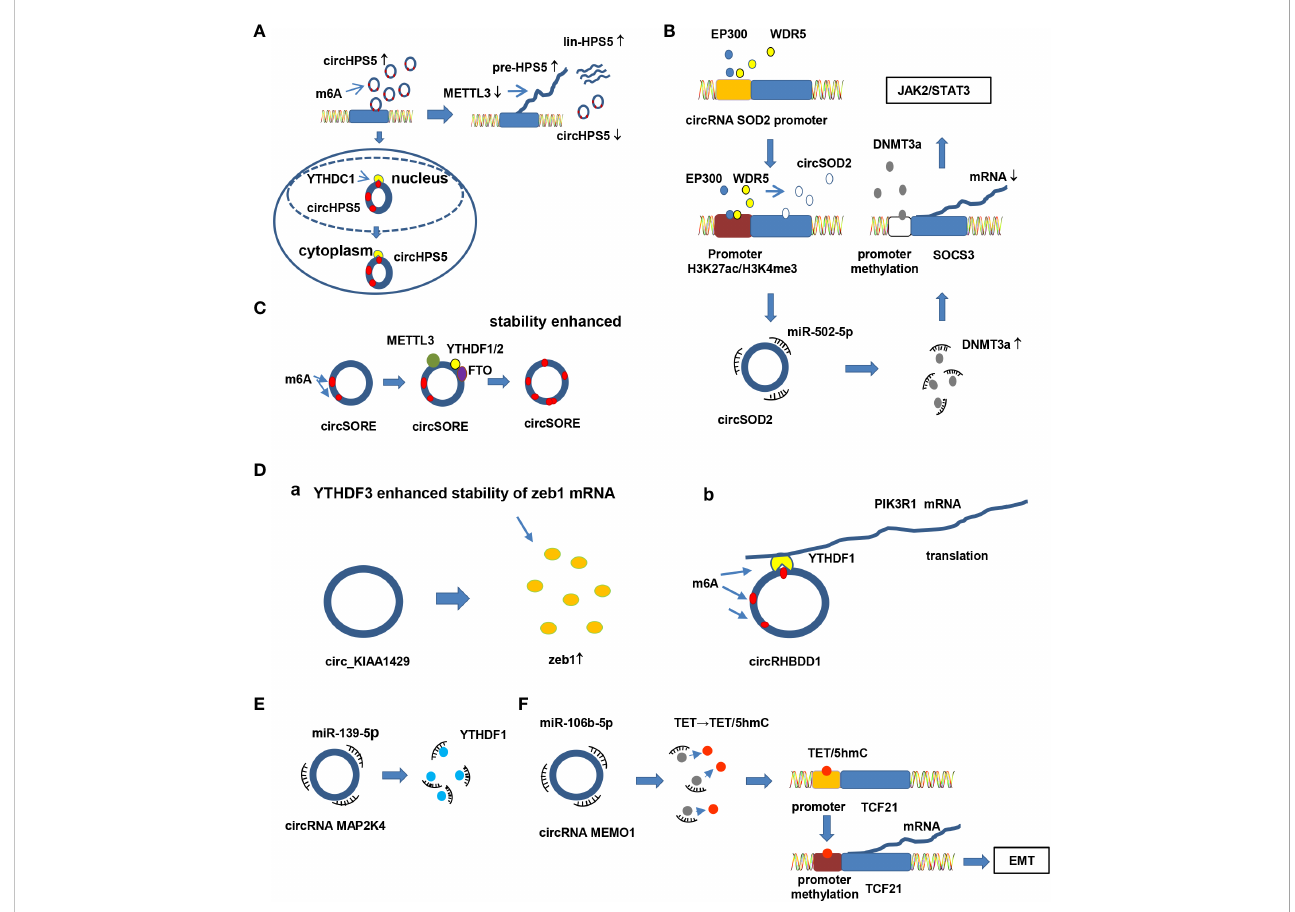
FIGURE 4 Crosstalk between circRNA and epigenetic modi fi cation in HCC. (A) Epigenetic modi fi cation mediates circRNA splicing and export. CircHPS5 is overexpressed in neoplastic HCC tissues and cells and promotes EMT and CSCs in HCC. Knockdown of METTL3 apparently suppresses circHPS5 but enhances pre-HPS5 and lin-HPS5 expression. Moreover, YTHDC1 enhances the cytoplasmic output of circHPS5 by binding to m6A-modi fi ed sites of circHPS5. Knocking down YTHDC1 increases the amount of nuclear circHPS5. (B) Proteins bind to the promoter region of circRNAs, promoting expression of circRNAs by modifying epigenetic modi fi cation of the promoter. For example, EP300 and WDR5 bind to the promoter region of circRNA SOD2, inducing epigenetic modi fi cation (H3K27ac and H3K4me3). The modi fi ed promoter increases circRNA SOD2 expression. Overexpression of circSOD2 modulates progression of HCC by suppressing miR-502-5p and activating DNMT3a. Moreover, activated DNMT3a inhibits SOCS3 expression by triggering DNA methylation of the SOCS3 promoter and activating the JAK2/STAT3 pathway. (C) m6A enzymes directly bind to circRNAs and increase the stability of circRNAs by increasing m6A levels in circRNAs. For example, METTL3, FTO and YTHDF1/2 directly bind to circSORE and increase its stability by elevating the level of m6A at a speci fi c adenosine. (D) CircRNAs interacting with proteins and m6A modi fi cation impact interaction between circRNA and proteins. For example, a) circ_KIAA1429 enhances zeb1 expression levels, and YTHDF3 improves the stability of Zeb1 mRNA in an m6A- dependent manner; b) YTHDF1 binds to the m6A modi fi cation site of circRHBDD1; YTHDF1 also binds to PIK3R1 mRNA in an “ m6A ” -dependent manner to promote PIK3R1 expression, thereby facilitating HCC progression. (E) CircRNAs regulate expression of enzymes involved in m6A by targeting miRNAs. For example, circRNA MAP2K4 regulates expression of YTHDF1 by sponging miR-139-5p. (F) CircRNAs modulate the epigenetic modi fi cation of target proteins by sponging miRNAs. For instance, circRNA MEMO1 promotes 5hmC of TET by sponging miR-106b-5p. However, 5hmC of TET facilitates the EMT process by inducing promoter methylation of TCF21, promoting expression of